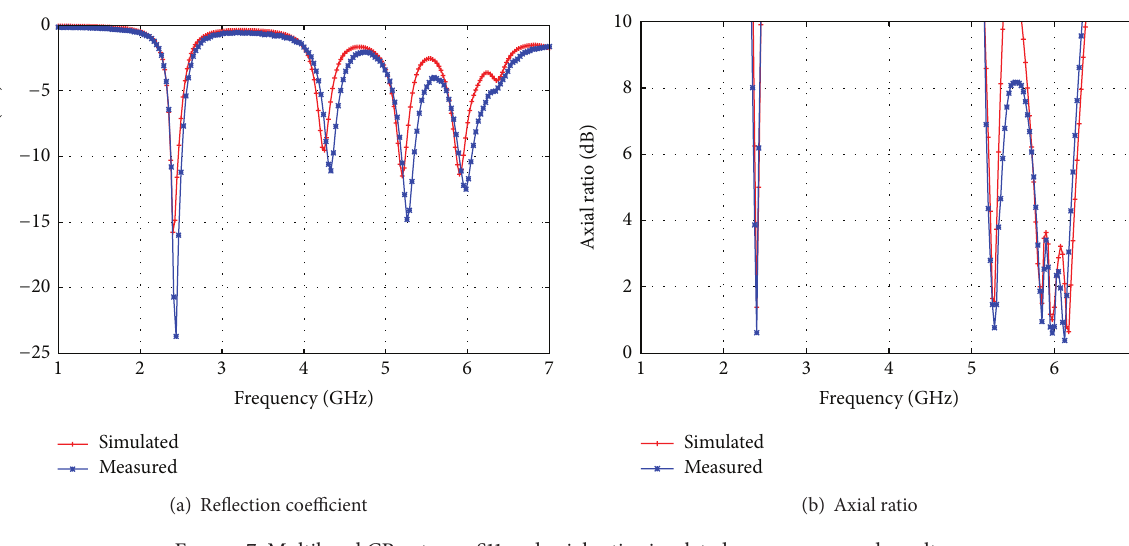
Figure 7: Multiband CP antenna S11 and axial ratio simulated versus measured